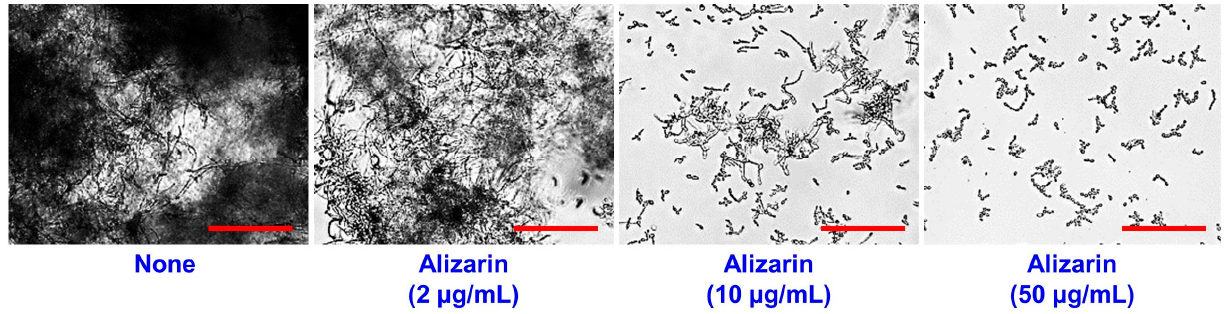
Figure 5. Effects of alizarin on C. albicans aggregation and filamentous growth. Cell aggregation was investigated in RPMI medium having 10% fetal bovine serum. Scale bars represent 100 µm.